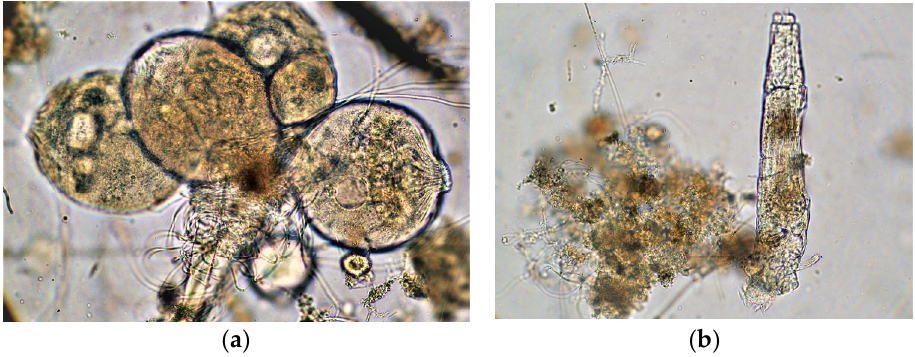
Figure 6. Observed microorganisms of activated sludge: ( a ) Stalked ciliates; ( b ) Rotifer.